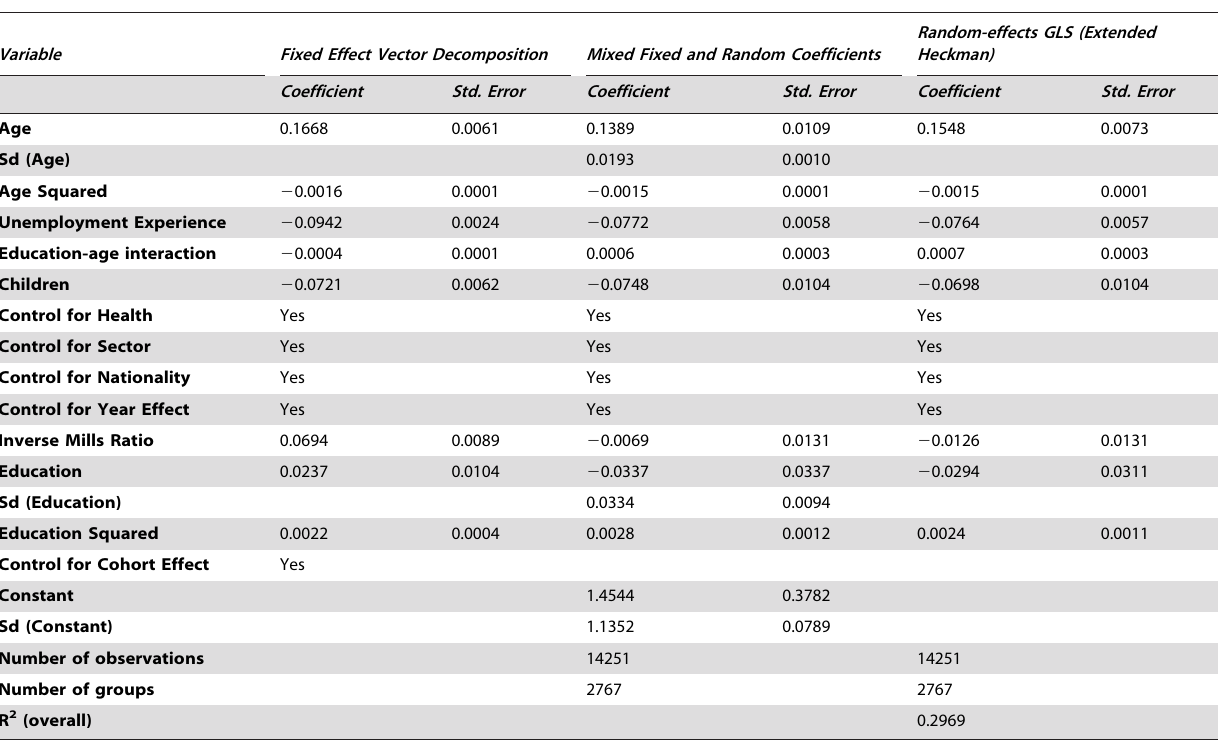
Table 3. Wage Function Estimates for Women 1996–2003.